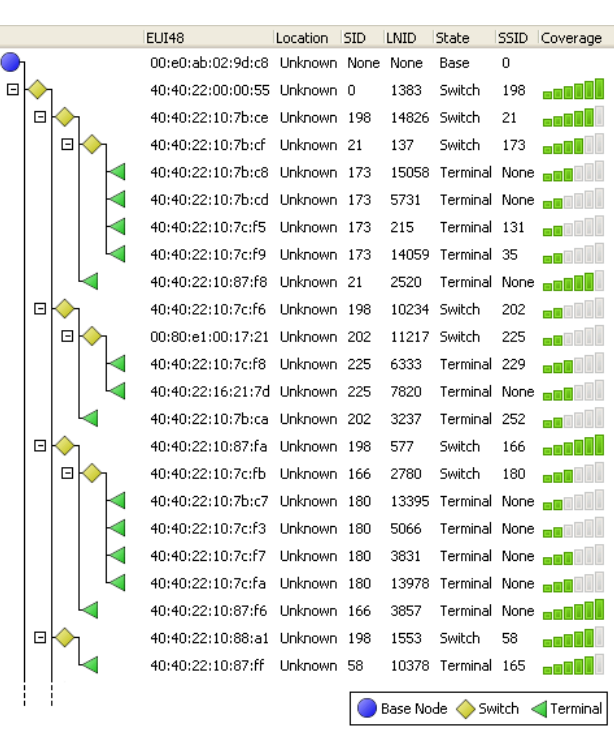
Figure 2. Example of PLC PRIME